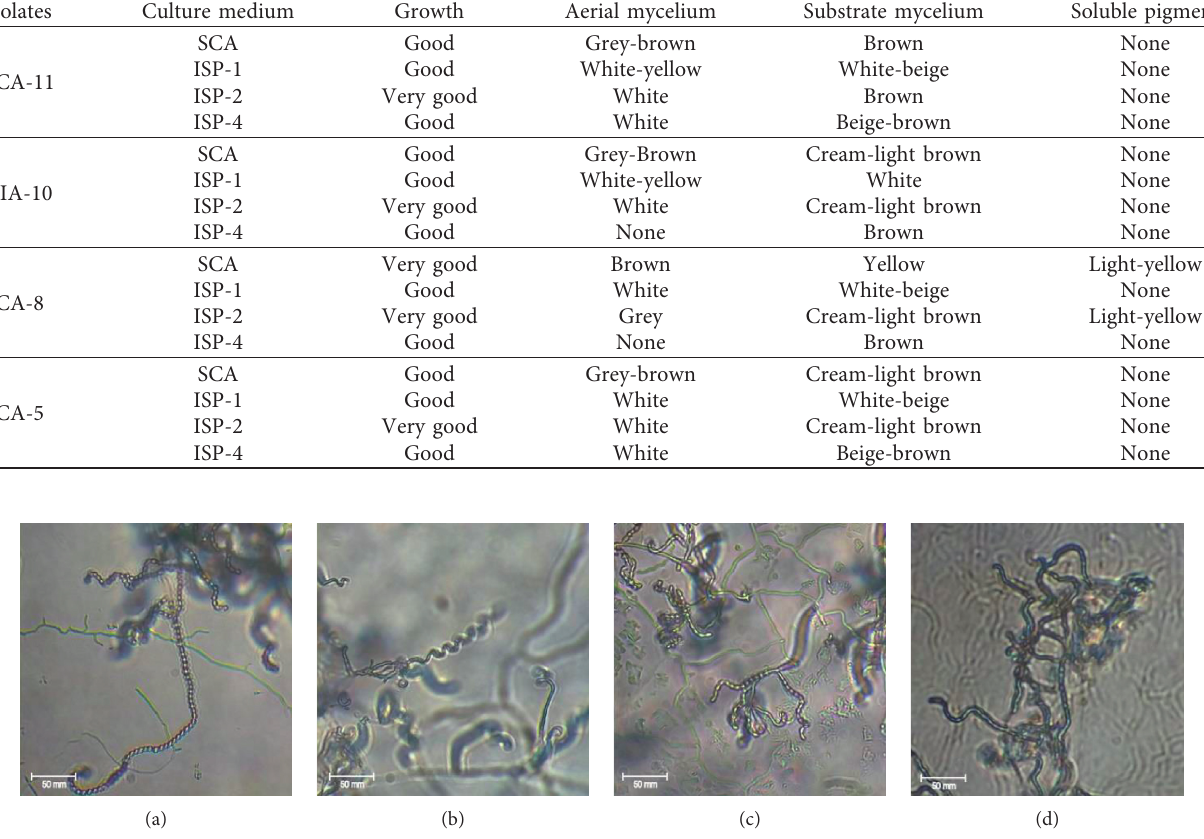
Figure 3: Microscopic morphology of selected Streptomyces examined by using a light microscope (1000 × ): (a) SCA-5, (b) SCA-8, (c) SCA- 11, and (d)